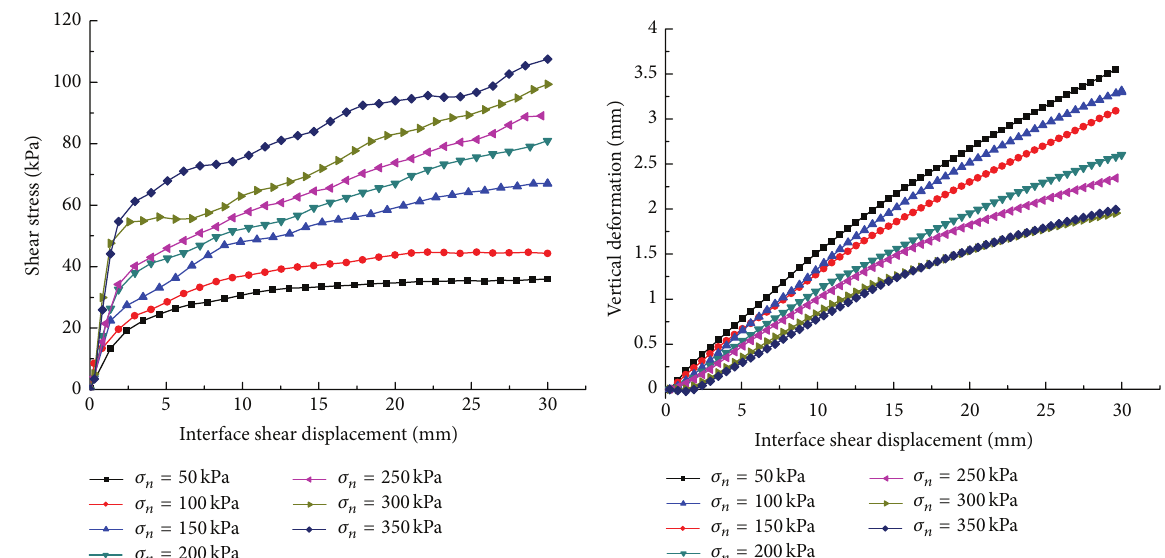
Figure 5: Test results for the interface between clay and #2 plate (initial normal stress of 400kPa).